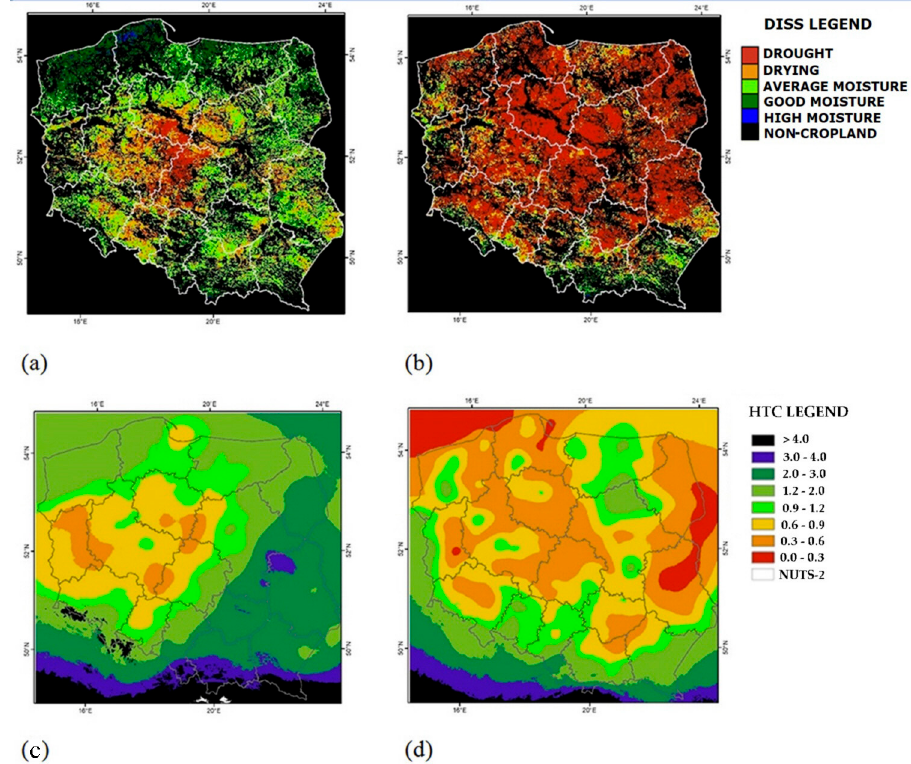
Figure 14. Comparison of the DISS index ( a , b ) and the corresponding HTC ( c , d ) across Poland. ( a ) DOY 149, 2015 and ( b ) DOY 171, 2018—DISS, ( c ) DOY 149, 2015 and ( d ) DOY 171, 2018—HTC.